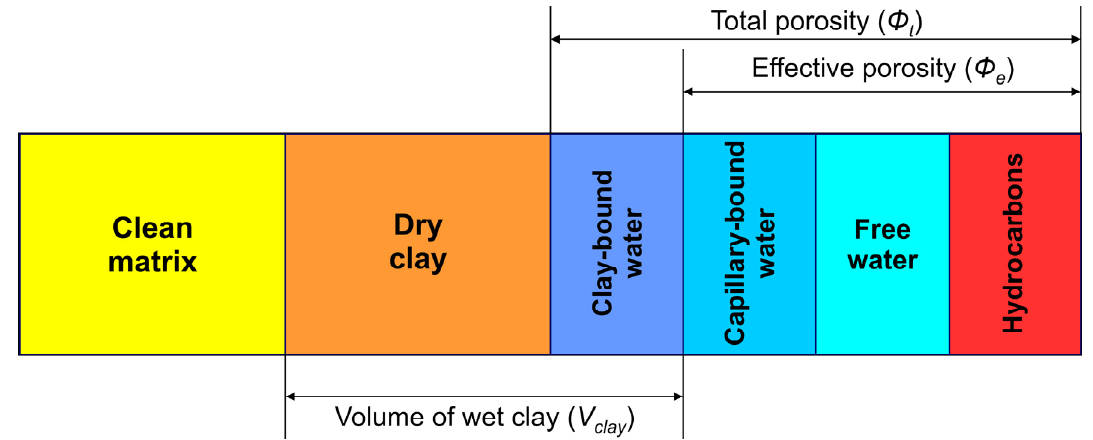
6 Figure 6. Volumetric representation of the “shaly sands” petrophysical model adopted for the quantitative interpretation of well